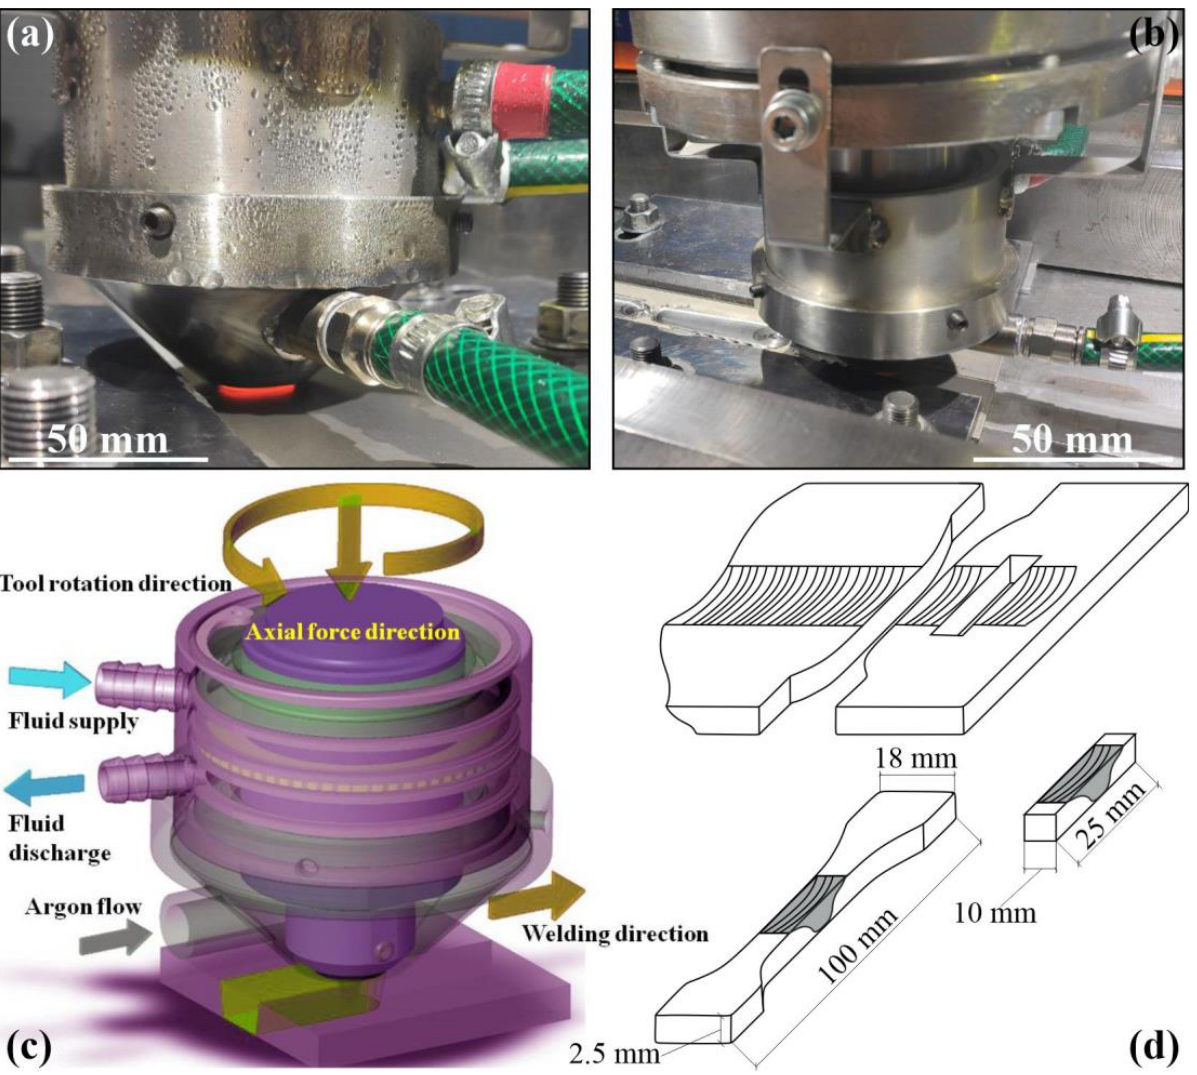
Figure 1. General view of the FSW process ( a , b ); schematic of friction stir welding of titanium alloys with an argon gas blanket of the welding joint and liquid tool-cooling ( c ); schematic of a cross-sectional specimen and tensile specimen ( d ).